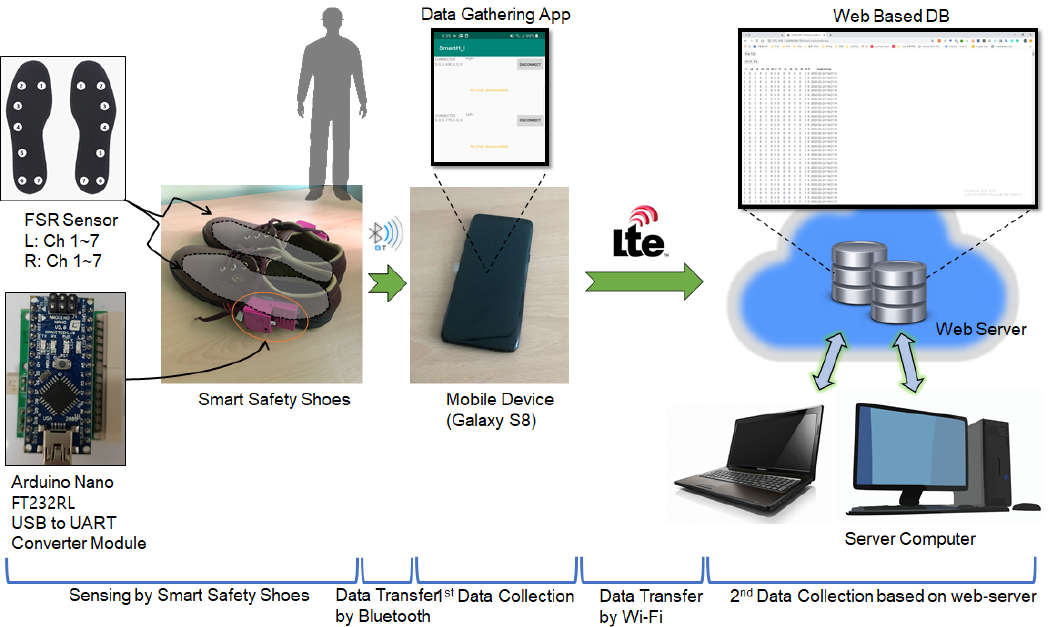
Figure 1. The Configuration diagram of smart safety boots system.